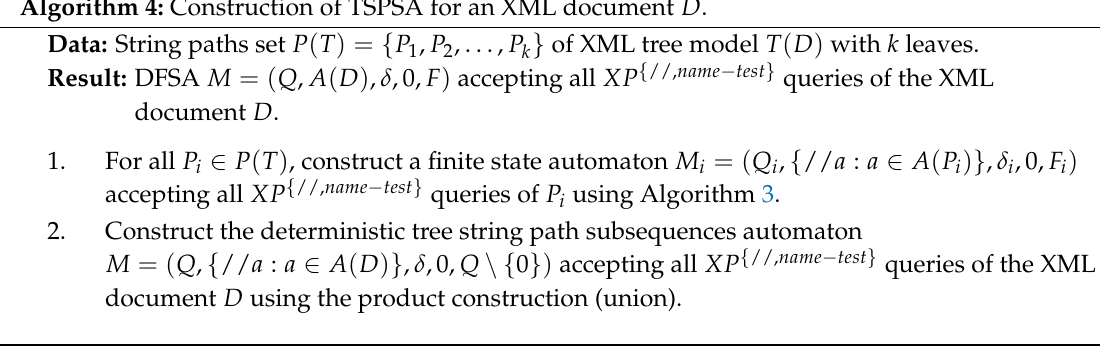
Algorithm 4: Construction of TSPSA for an XML document D .